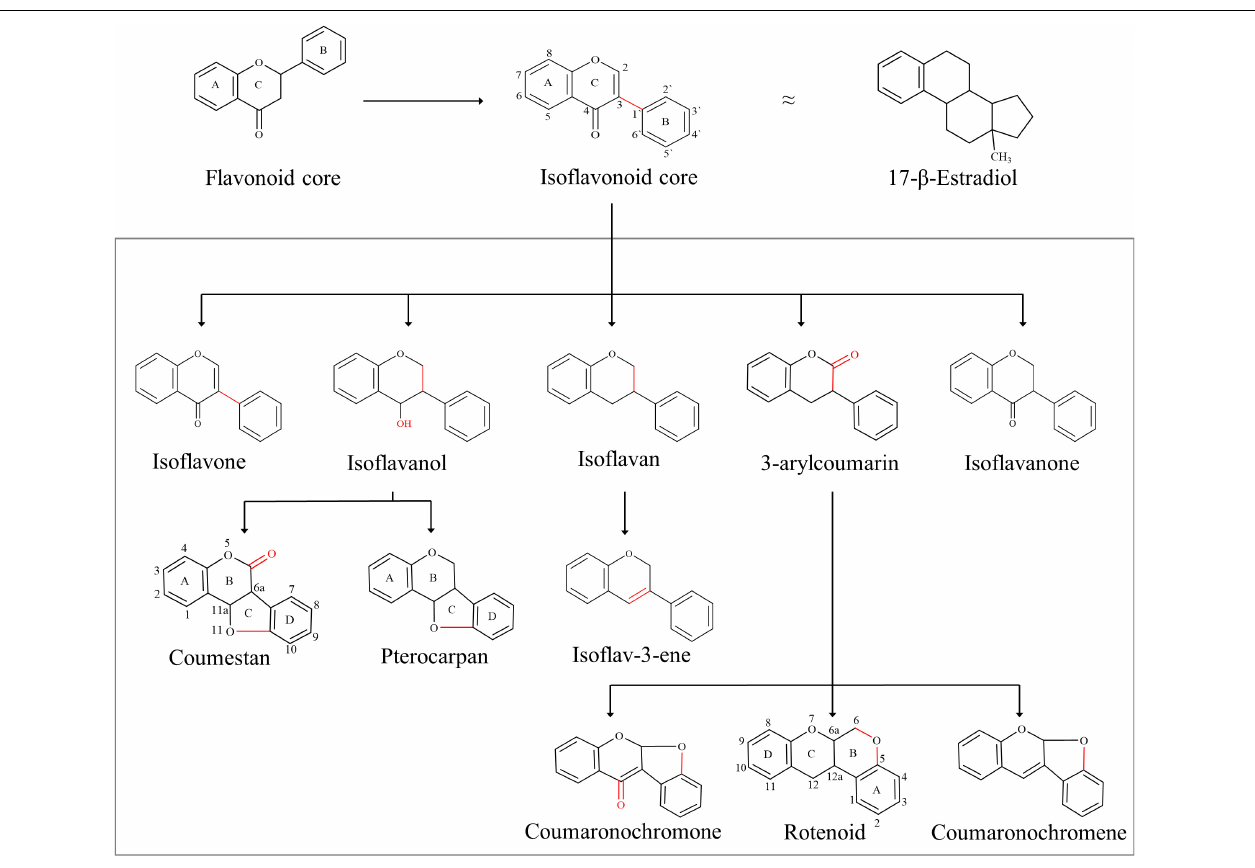
FIGURE 1 | Basic skeleton of isoflavonoids: isoflavonoids are structurally different to flavonoids, with the B-ring migration from position 2 to 3, which in turn leads to the structural similarities to estrogen, e.g., 17 β -estradiol. Isoflavonoid diversity is regulated by simple functional additions such as hydroxyl, which in turn can generate additional rings into the backbone, e.g., pterocarpan and coumestan. The addition of ketones can also generate additional rings, for example, rotenoid and